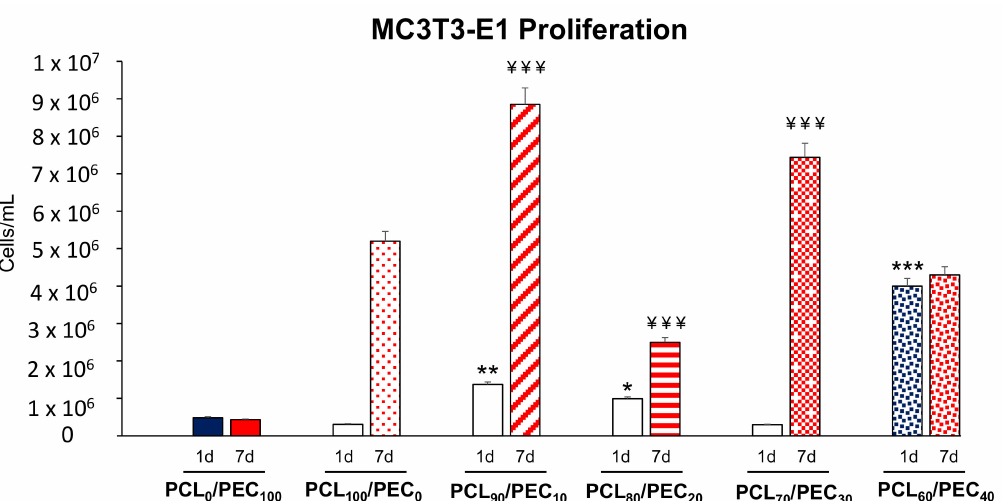
Figure 8. Cell proliferation (cells/mL) of the MC3T3-E1 pre-osteoblasts cultured on PCL/PEC films during 1 and 7 days. * p < 0.05, ** p < 0.01 and *** p < 0.005 vs. PCL 100 /PEC 0 at 1 day of culture.